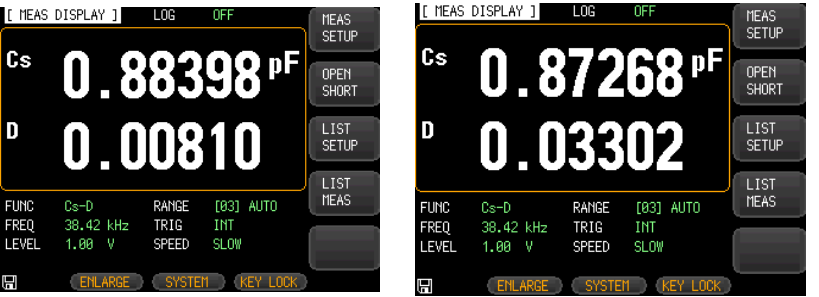
Figure 14. Interface capacitance test (driving capacitance).